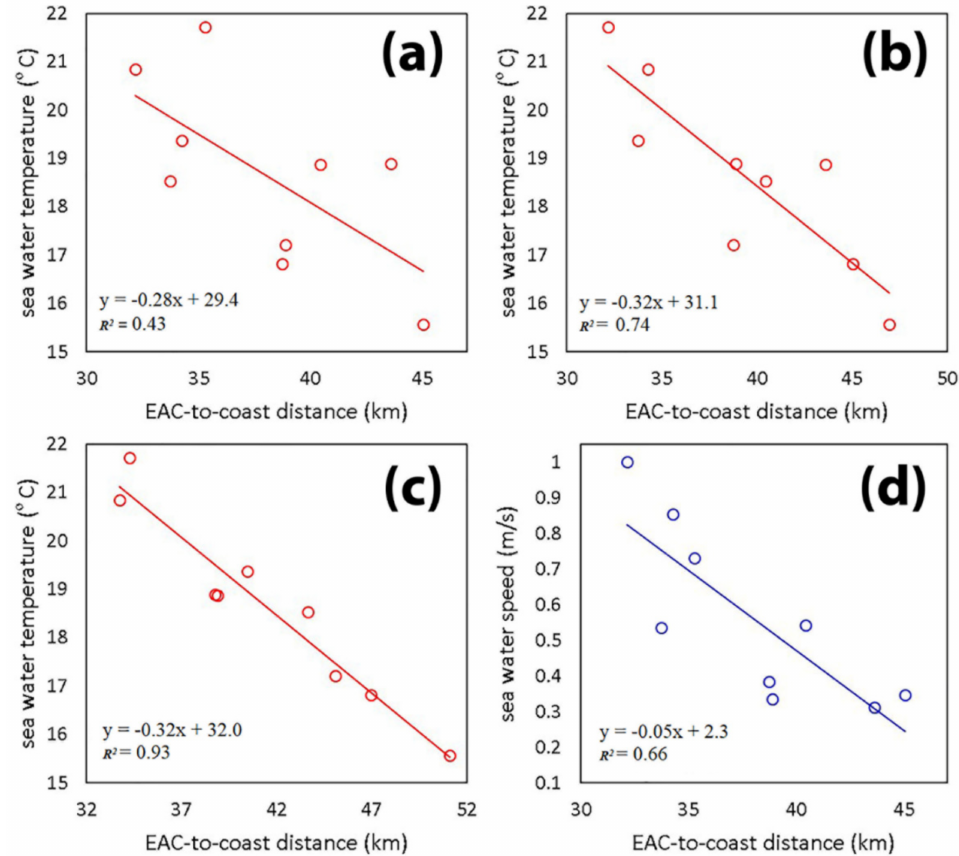
Figure 6. Linear relationship between the EAC-to-coast distance and bottom ocean temperature ( a ) no lag, ( b ) 1-day lag, ( c ) 2-day lag, and ( d ) surface current speed (no lag). N = 9 (14–22